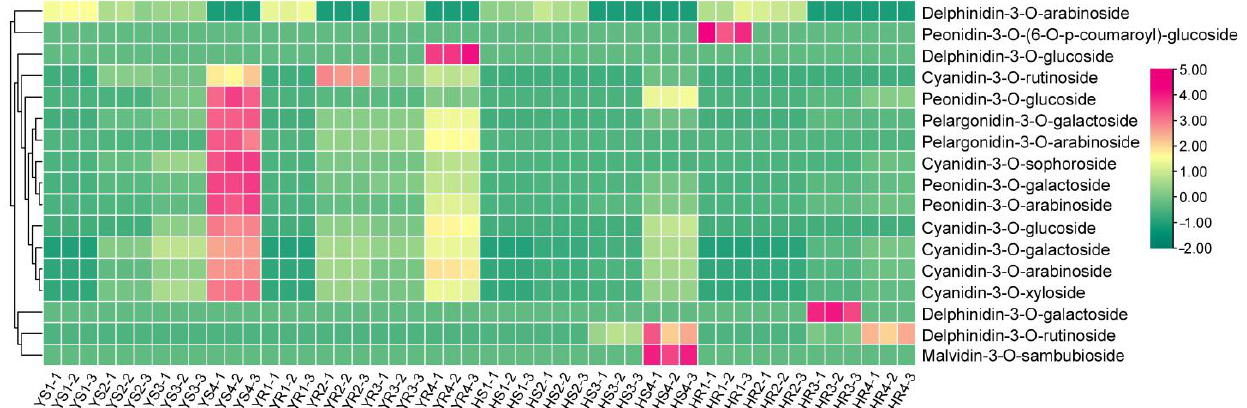
Figure 2. Heat map of anthocyanin content measured in each sample. YS and YR represent Huashuo and Huarui apples in the high-altitude orchard, respectively; HS and HR represent Huashuo and Huarui apples in the low-altitude orchard, respectively. YS1, YS2, YS3, and YS4 represent the four color transition periods of YS. The same rationale was applied to the other samples. The sample from each period consisted of three repetitions (e.g., YS1-1, YS1-2, and YS1-3).